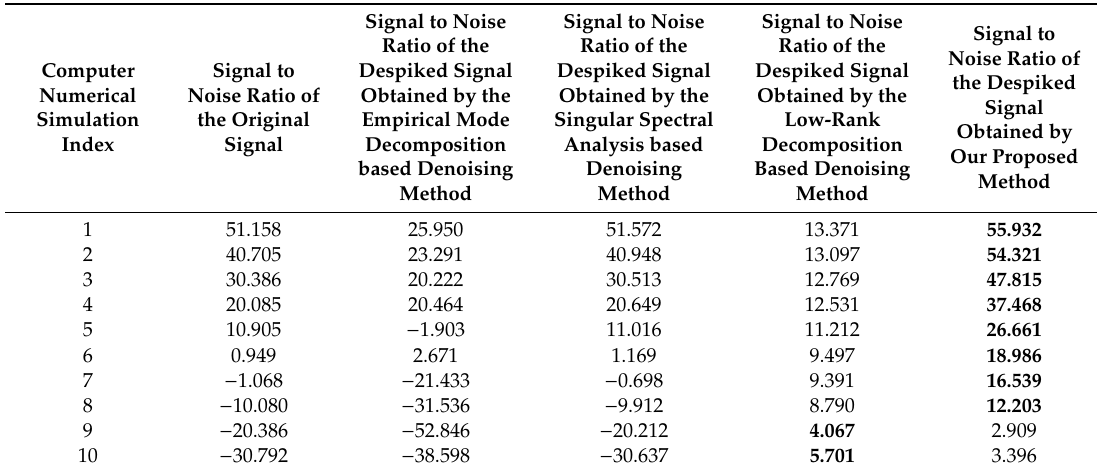
Signal to Noise Ratio of the Despiked Signal Obtained by Our Proposed